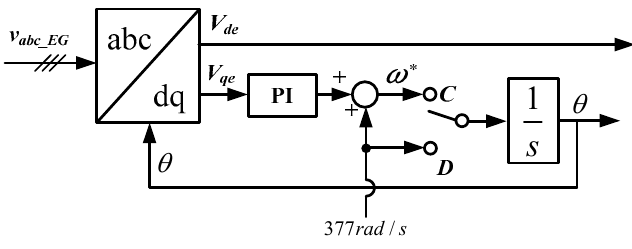
Figure 9. Phase ‐ locked loop (PLL) for EG phase angle tracking. Figure 9. Phase-locked loop (PLL) for EG phase angle